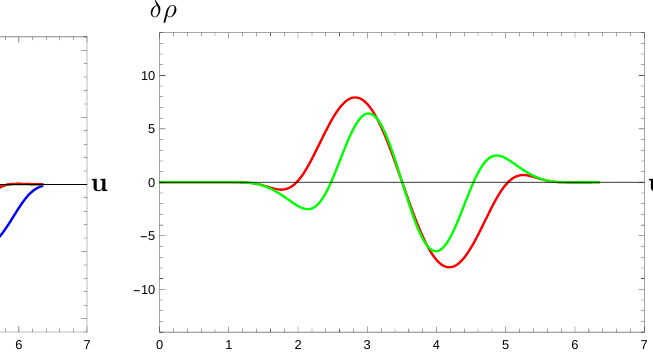
Figure 13. Plot of (cid:14)(cid:26) for two negative ranges, N = 33 (red) & N = 73 (green).